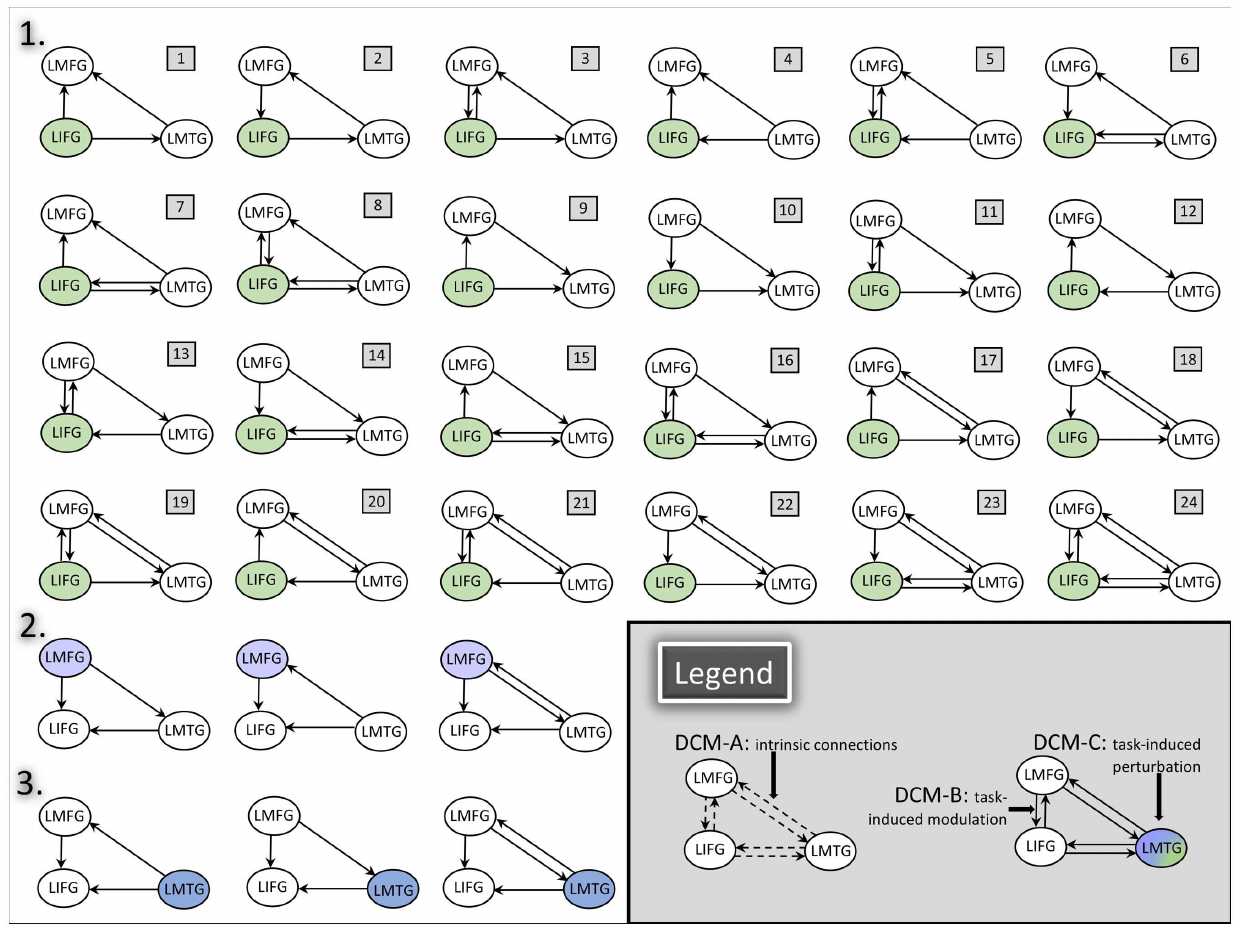
FIGURE 4 | DCM model space. Full, bidirectional endogenous connections between all regions were modeled in DCM-A. For each model, driving input to only one region was modeled in DCM-C. All possible combinations of uni- and bidirectional modulations were modeled across the model space; for each model, the input region modulated at least one other region in DCM-B. The full model space for all 24 models in Family #1 is schematized in the figure above (1) . Family #2 included models with the same modulatory connections as Family #1 with three additional models (2) and excluding models #1, #4, and #7 due to lack of modulation from LMFG to the other two regions. Similarly, Family #3 included models with the same modulatory connections as Family 1 with three additional models (3) and excluding models #9, #10, and #11 due to lack of modulation from LMTG to the other two